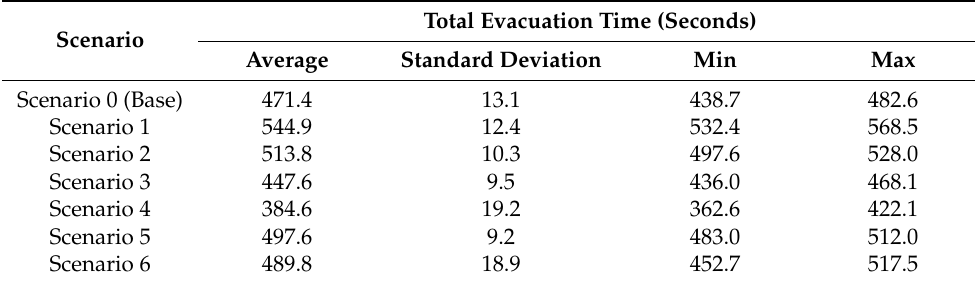
Table 7. Analyzed total evacuation time to assembly point 2 for all scenarios.